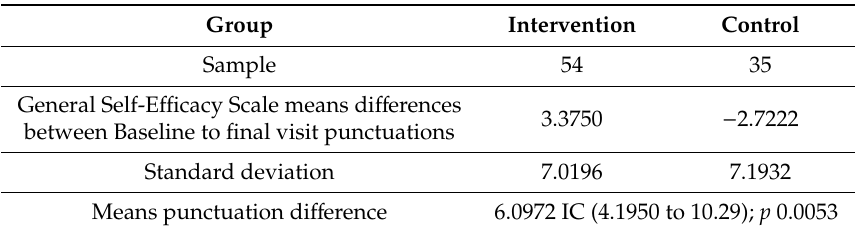
Table 3. Hypothesis test for means di ff erence between